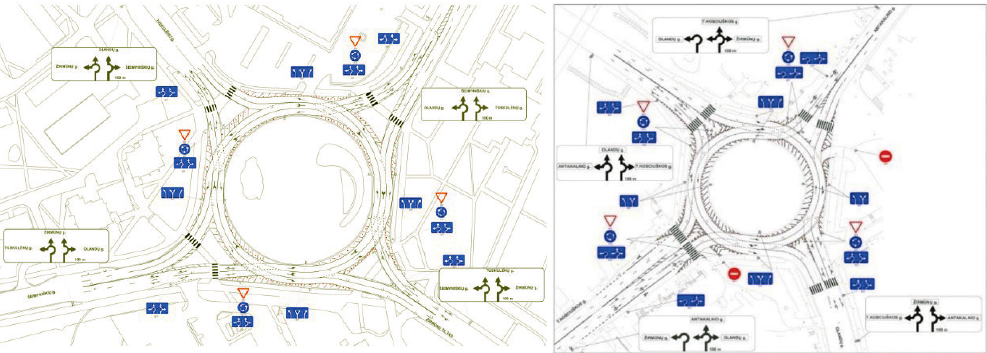
Figure 5. The implemented traffic organisation schemes in August 2016 (“Žirmūnai Roundabout” on the left side and “Olandai Roundabout” on the right side)